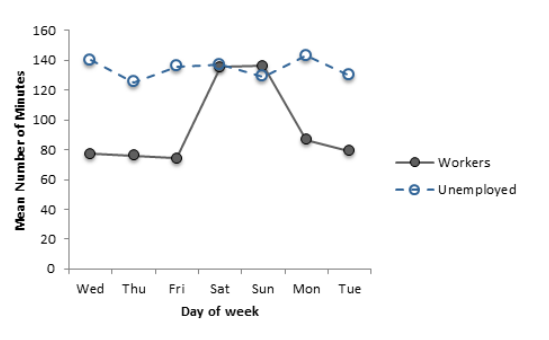
Figure 4: Time on housework by day of week. From American Time Use Survey,